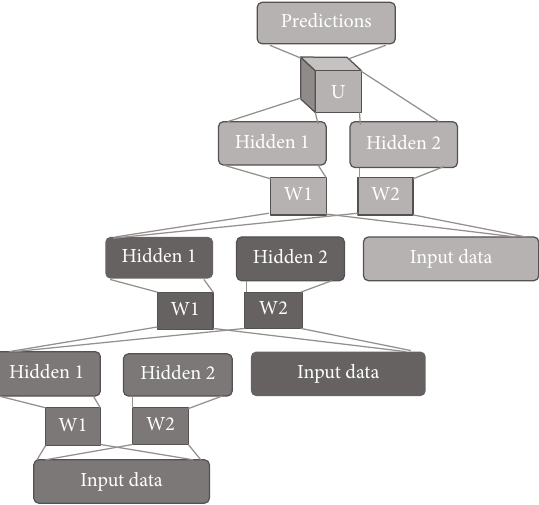
Figure 4: TDSN modules stacking by two hidden-layer concatenating with input vector.